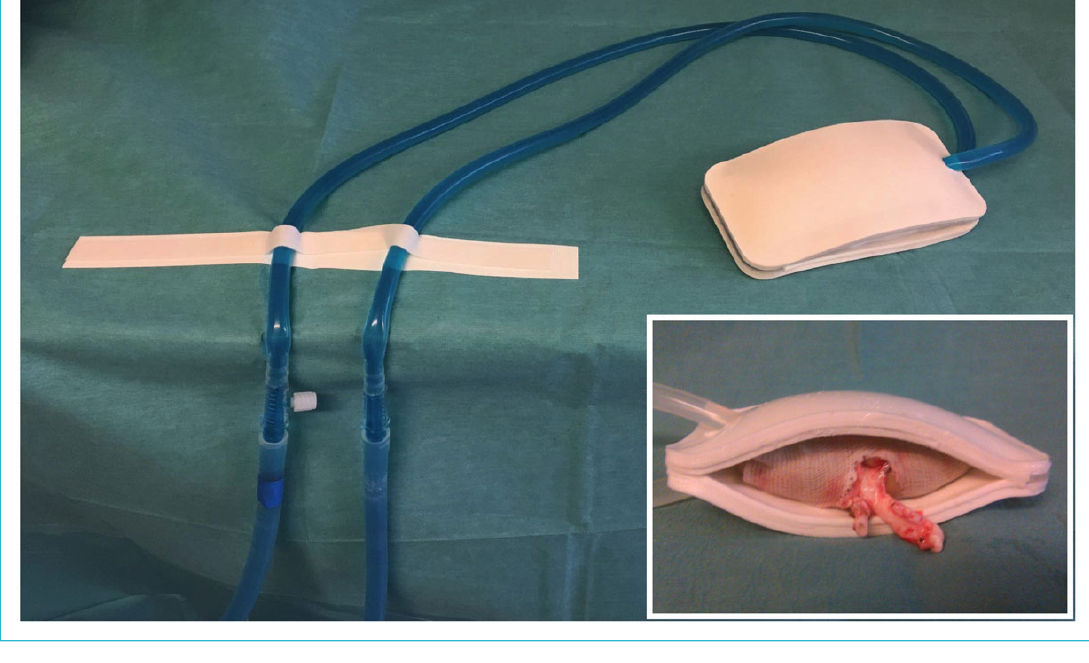
Figure 1: The cooling device. The cooling device is a watertight double sheath of silicone surrounding the kidney and continuously perfused via a tubing system with ethanol and methylene blue at 4°C. Inset: kidney with the perfused cooling device.